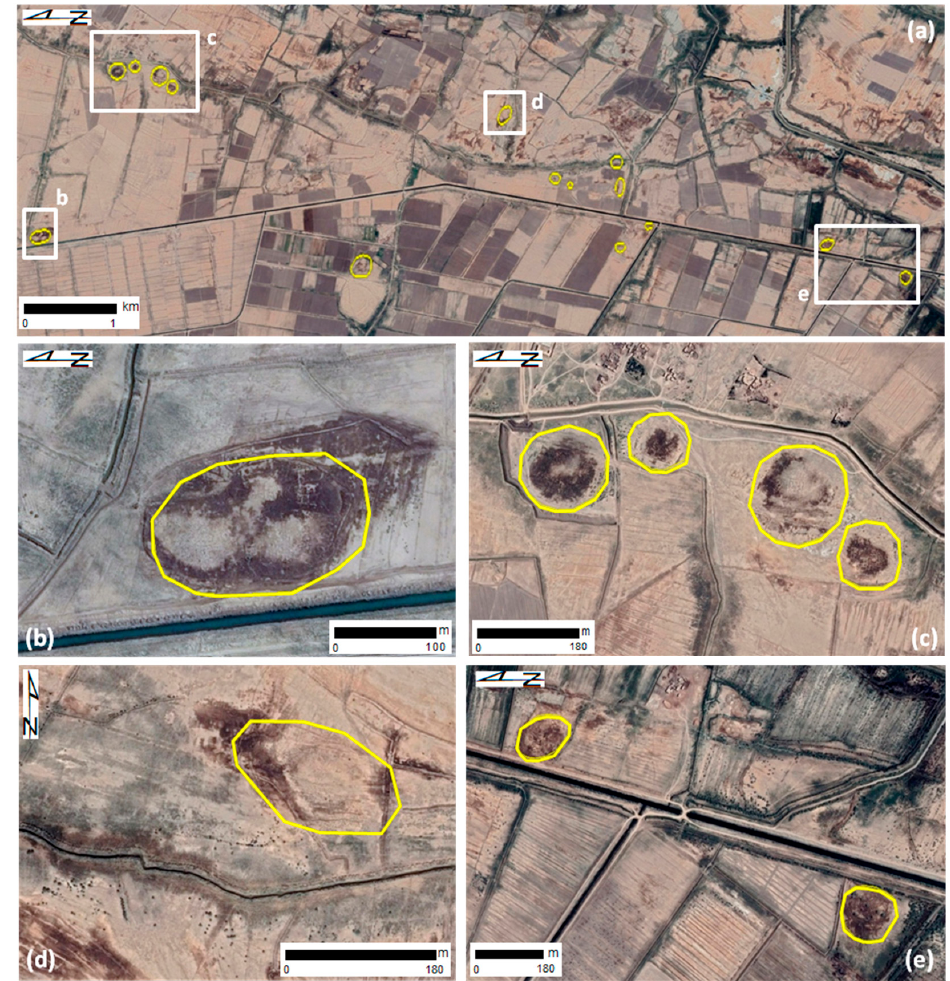
Figure 15. ( a ) Overview of the tells located in the eastern part of the test area (see also Figure 11f; precise location undisclosed for security concerns) that were affected by fire incidents, with indication of ( b – e ) zoomed views highlighting the burning patterns and scars, as captured by Google Earth image (©2021 Maxar Technologies) collected on 7 October 2013.